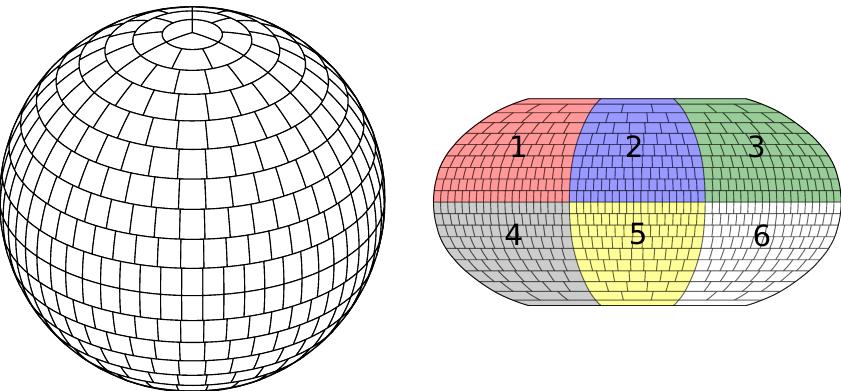
Figure 2. Grid used in Pangolin with 20 latitudes: orthographic projection (left) and Robinson projection, with the six identical zones highlighted